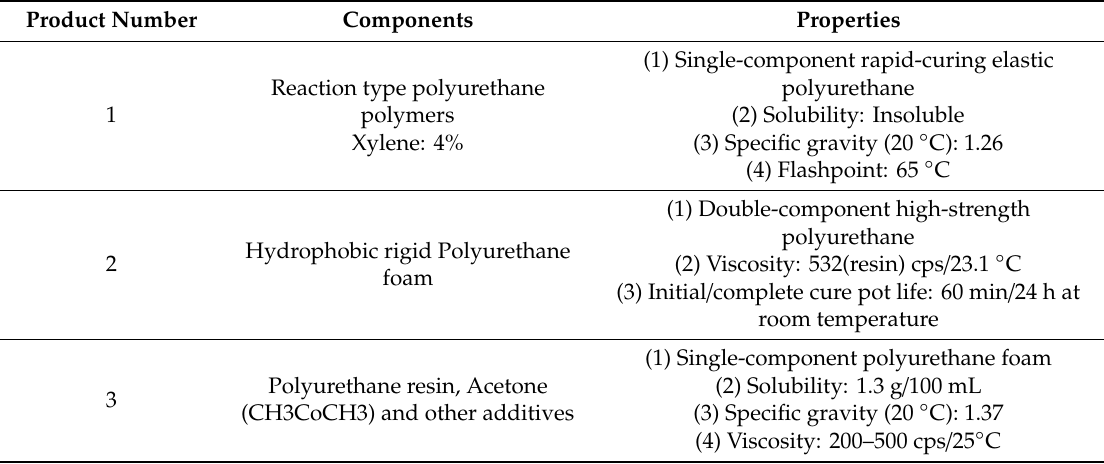
Table 4. The polyurethane-foam injection-grout material